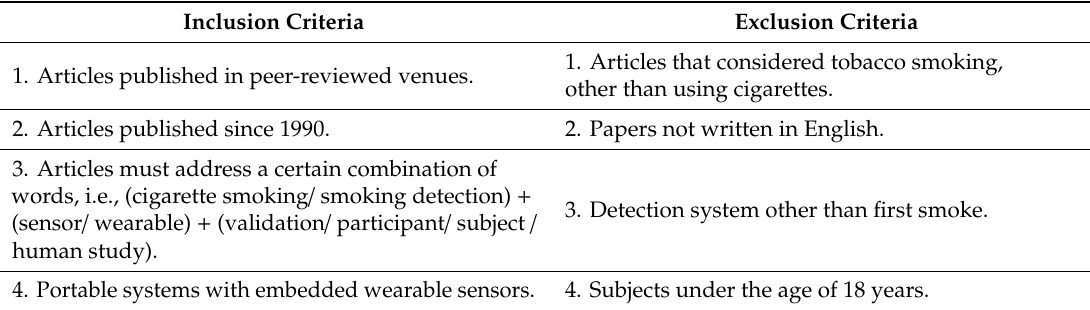
Table 1. Inclusion and Exclusion Criteria for the review.